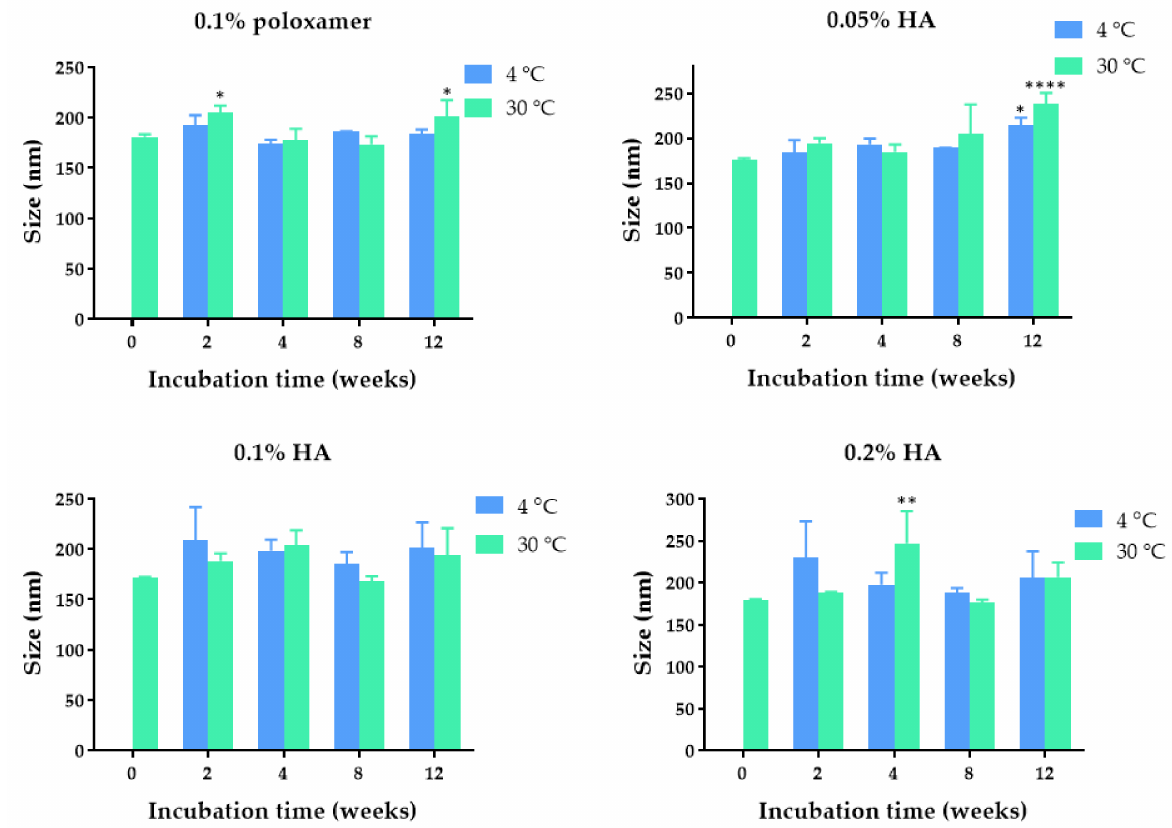
Figure 1. The hydrodynamic diameter of the quercetin-loaded PLGA NPs after fresh preparation and storage in deionized water for 2, 4, 8, and 12 weeks at 4 ◦ C and 30 ◦ C, respectively. *, **, and **** indicate p < 0.05, 0.01, and 0.0001 compared with day 0,